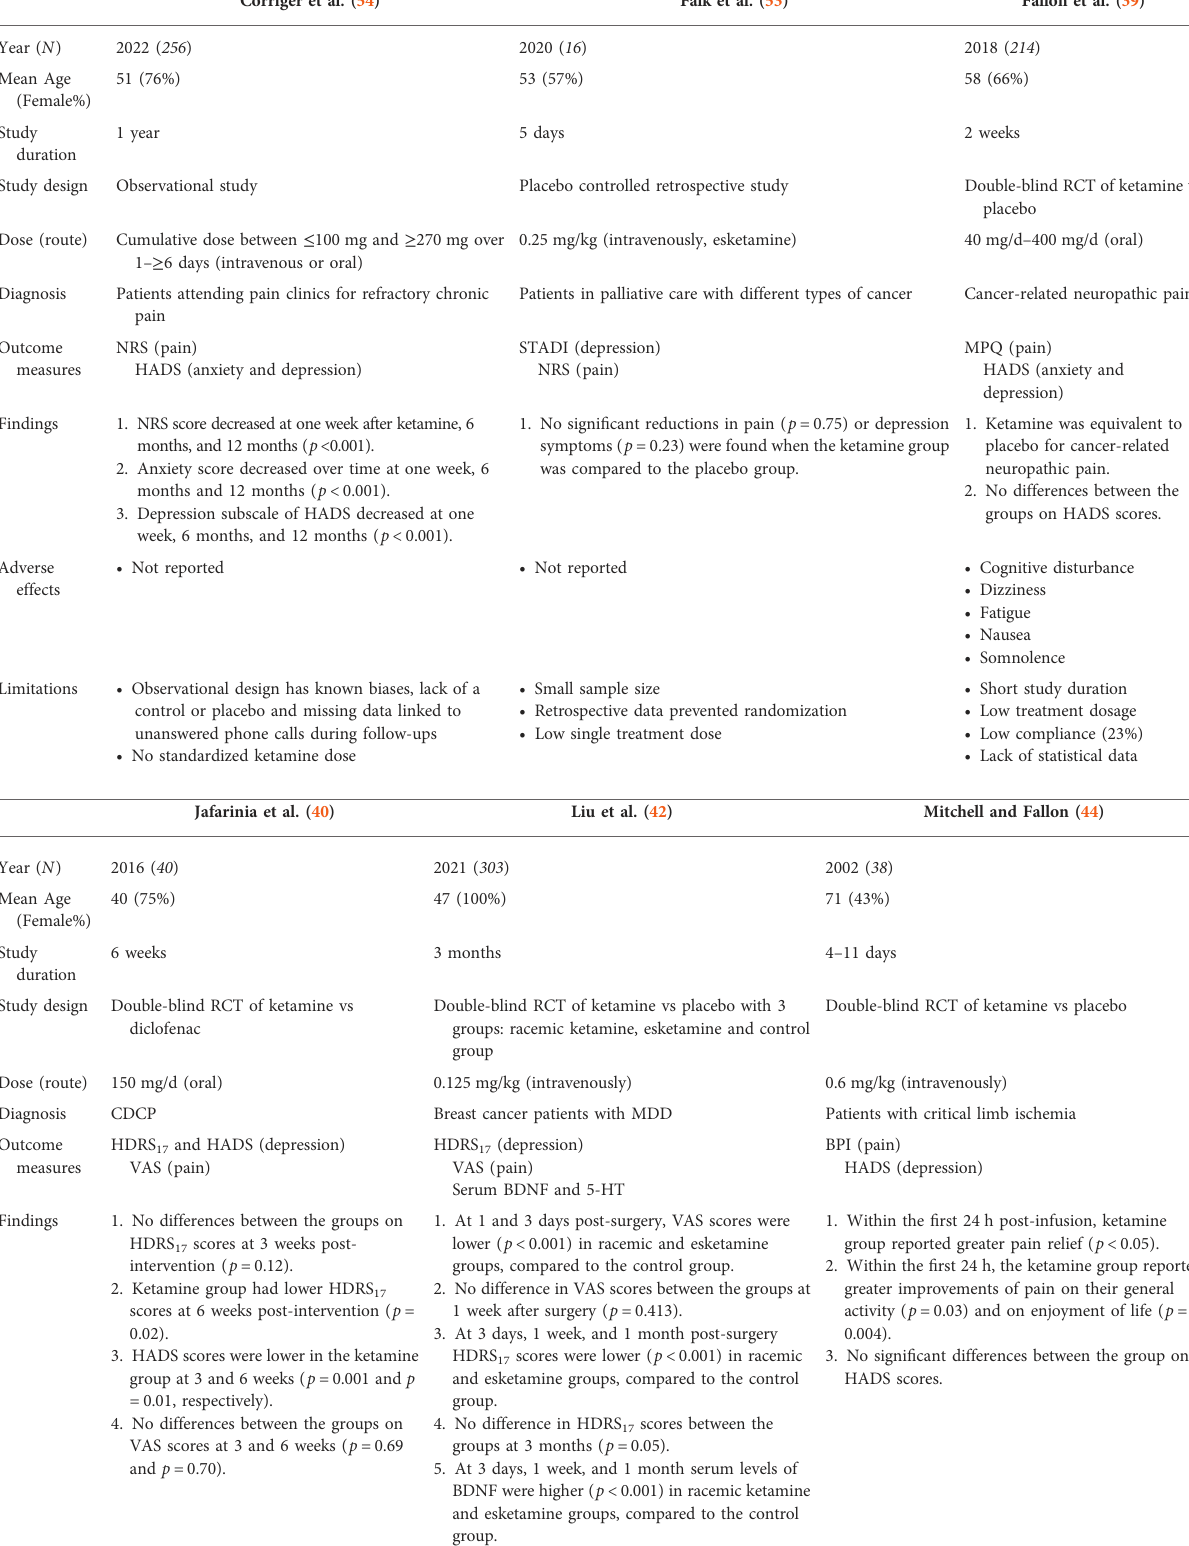
TABLE 1A Selected characteristics of clinical trials and observational studies pertaining to